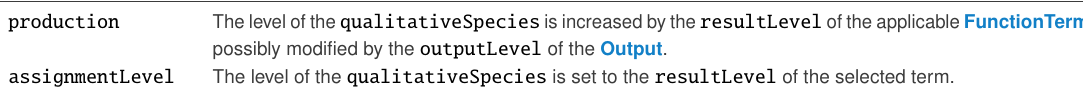
Table 2: Interpretation of the transitionEffect attribute on an Output . Note: as discussed in Section 3.6.3 on the next page the ’applicable FunctionTerm ’ refers to whichever FunctionTerm in the ListOfFunctionTerms evalutaes to “ true ” or the DefaultTerm if all of the FunctionTerm objects evaluate to “ false